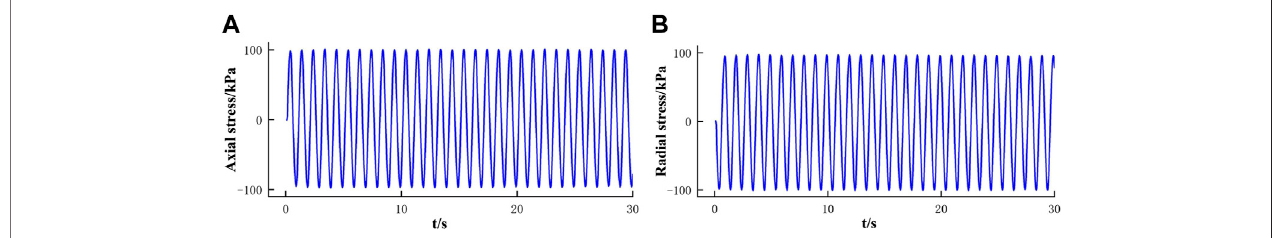
FIGURE 2 | Time – history curves measured under bidirectional vibrations: (A) Time – history curves of axial stress; (B) time – history curves of radial stress.